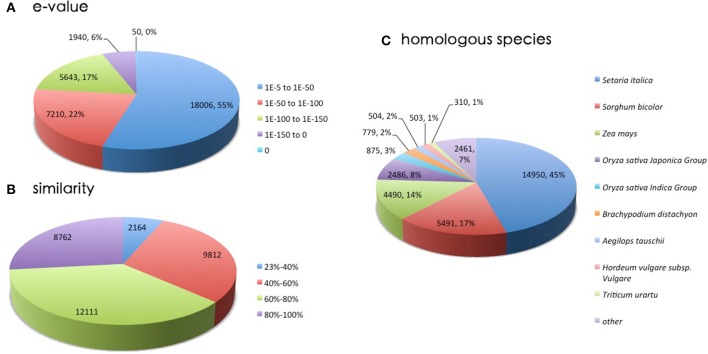
A homology search was conducted by BLASTx against the NR database. (A)
E-value distribution of BLAST hits for matched unigene sequences. (B) Similarity distribution of top BLAST hits for each unigene. (C) Species distribution of the top BLAST hits.